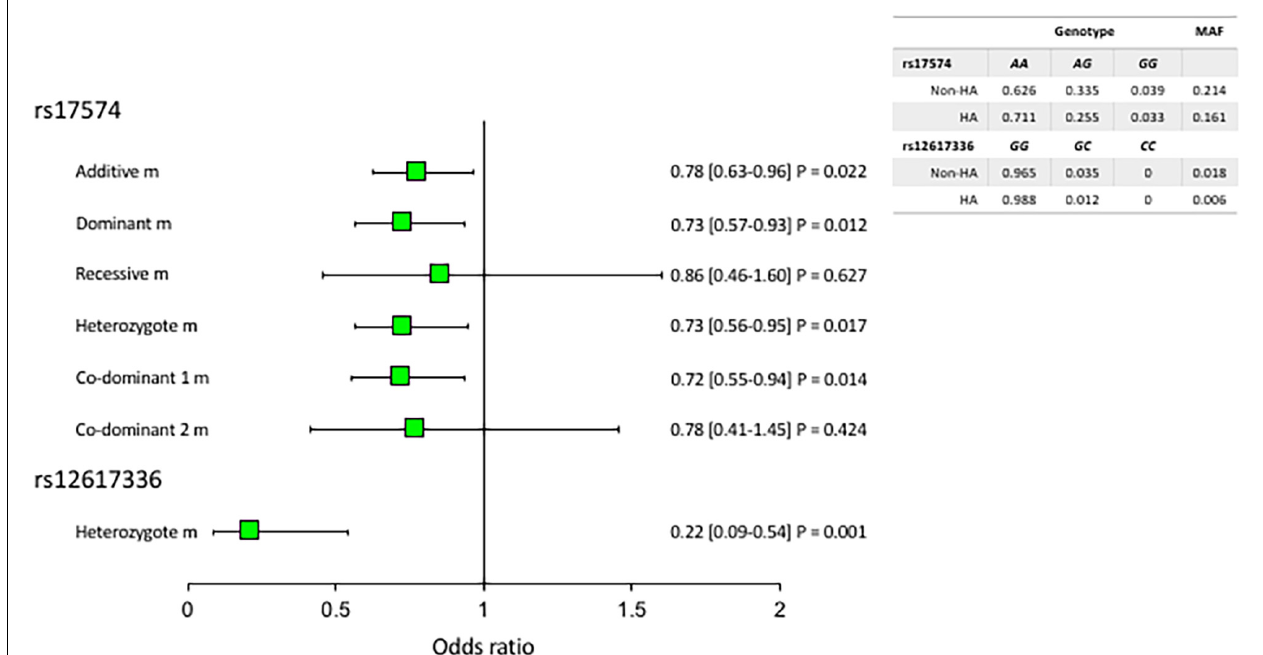
FIGURE 1 | Association of DPP4 polymorphisms with hypoalphalipoproteinemia. MAF, minor allele frequency. All models were adjusted by age, sex, BMI, current smoking, physical activity, visceral abdominal fat, and triglycerides levels. The reference genotype was GG for rs12617336 and AA for rs17574. HA: hypoalphalipoproteinemia; Non-HA: non-hypoalphalipoproteinemia.